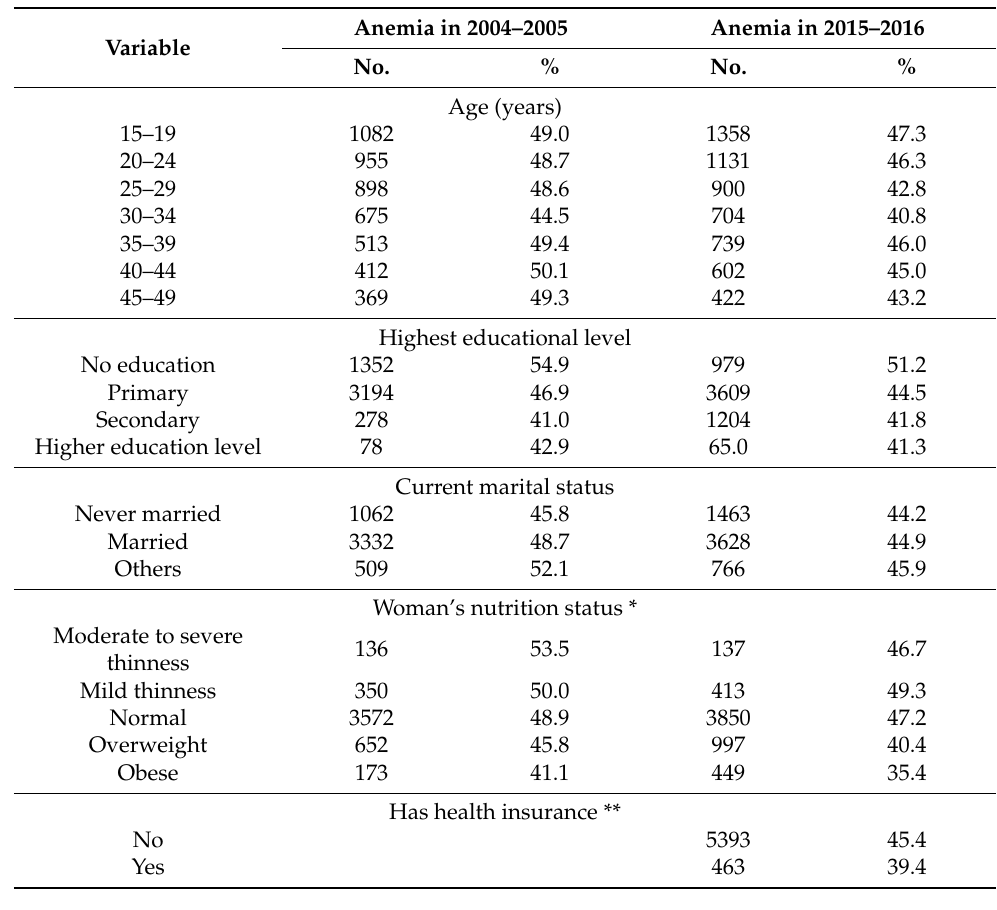
Table 2. Individual, household, reproductive, and child health characteristics in relation to the changing burden of anemia among WRA in